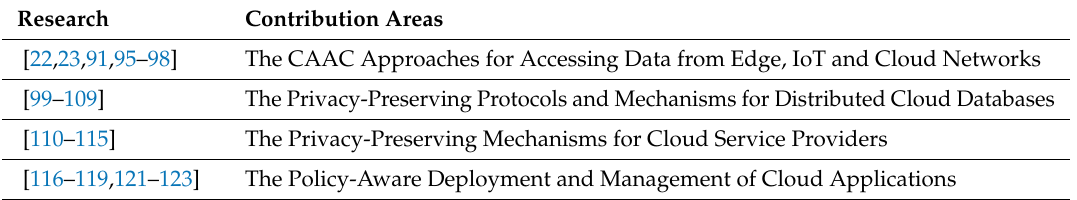
Table 5. The access control research and contribution areas in the decentralized networks.